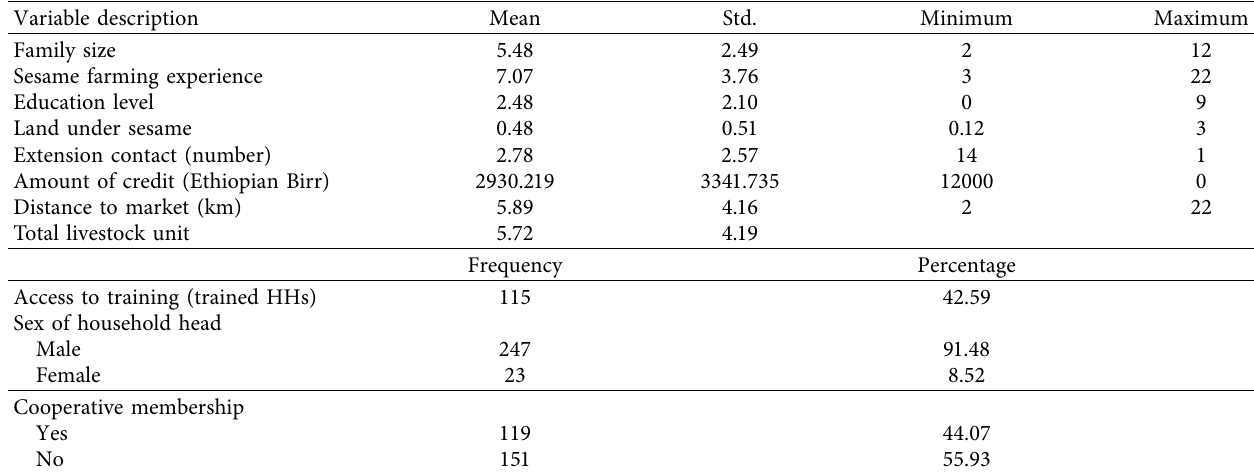
Table 3: Characteristics of sampled sesame